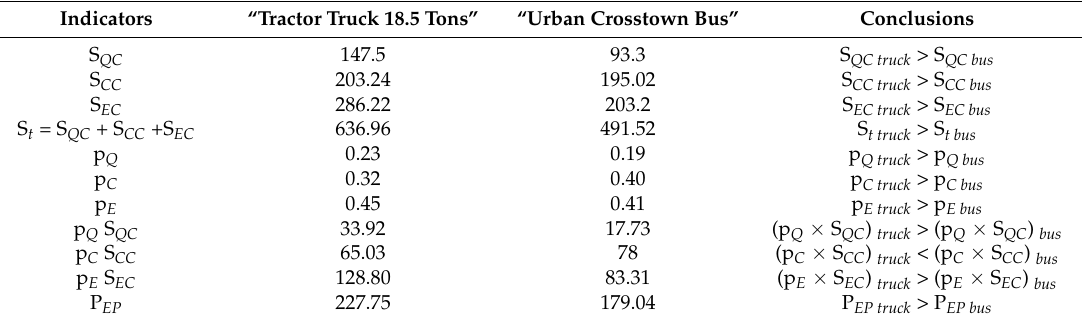
Table 8. The synthetic indicators of the “Tractor Truck 18.5 tons” and “ Urban Crosstown Bus ” products.